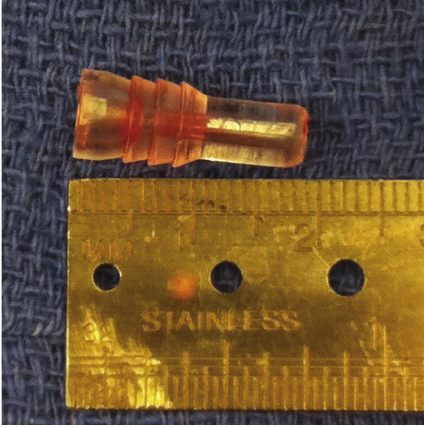
Figure 3: Broken tip of Bio-TransFix implant.